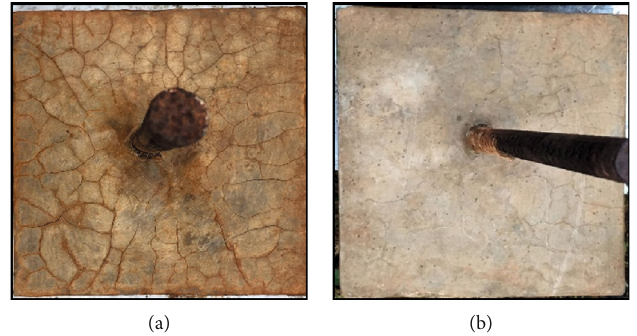
Figure 14: Cracks at (a) uncon fi ned specimen and (b) con fi ned specimen, with 16mm diameter vertical reinforcement.